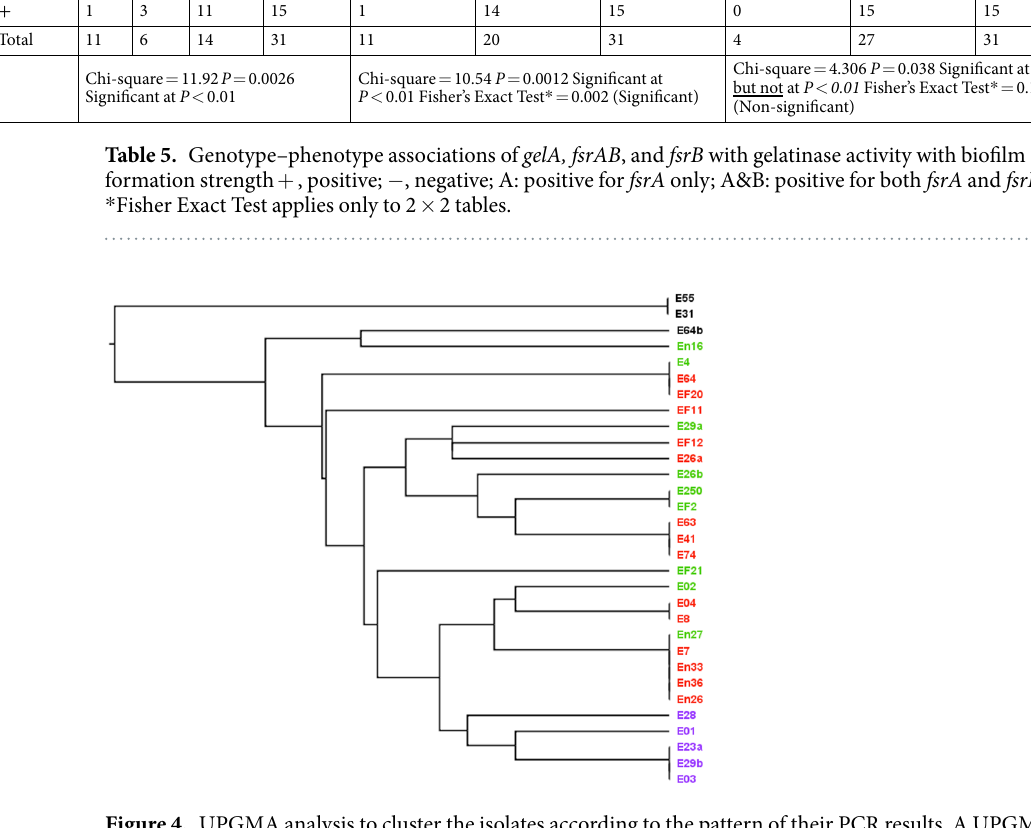
Figure 4. UPGMA analysis to cluster the isolates according to the pattern of their PCR results. A UPGMA cladogram representing the clustering relatedness of 31 isolates according to the pattern of their PCR results for biofilm-associated genes. Isolate names are color coded according to their biofilm strength (Purple, strong; Red, medium; Green, weak; Black,